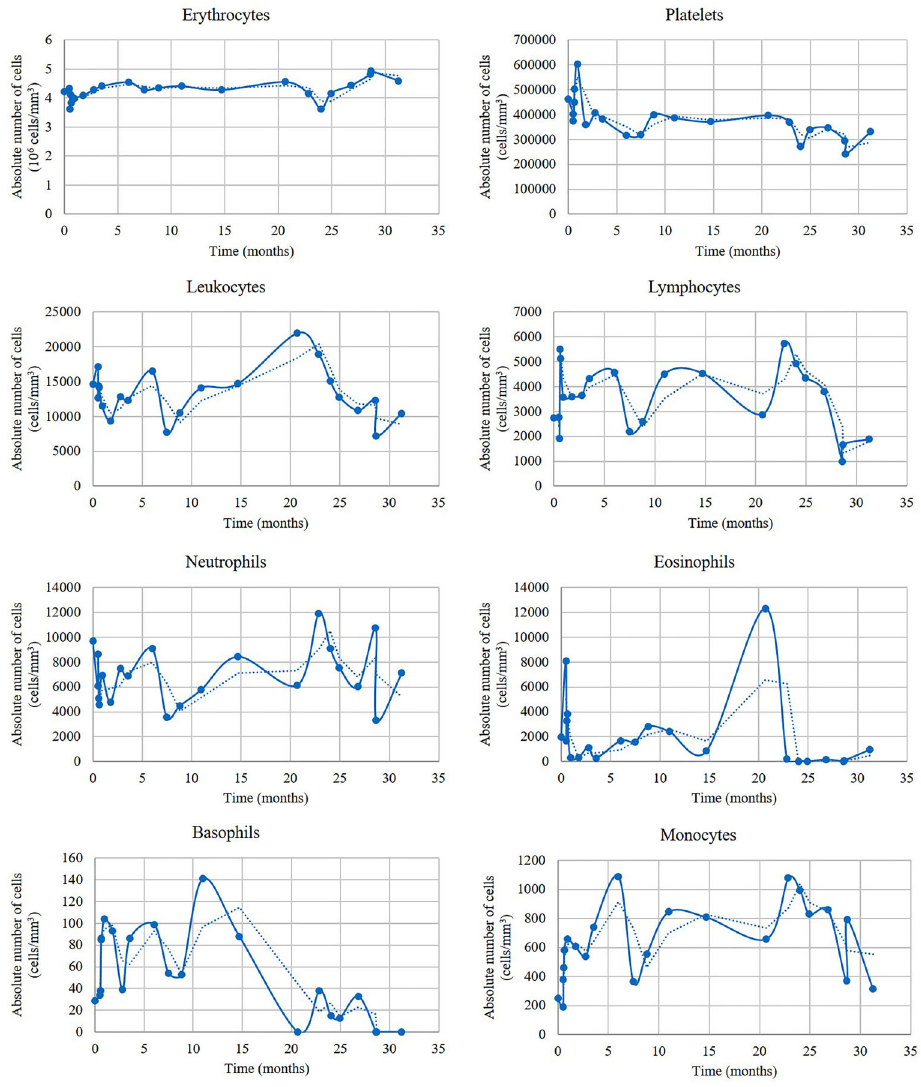
Figure 3. Serial blood cell counts after the patient began treatment. Dashed lines represent the simple moving average trend. Leukocyte counts, especially neutrophils and eosinophils, present a sinusoidal-like trend, suggesting a cyclic pattern. One could think